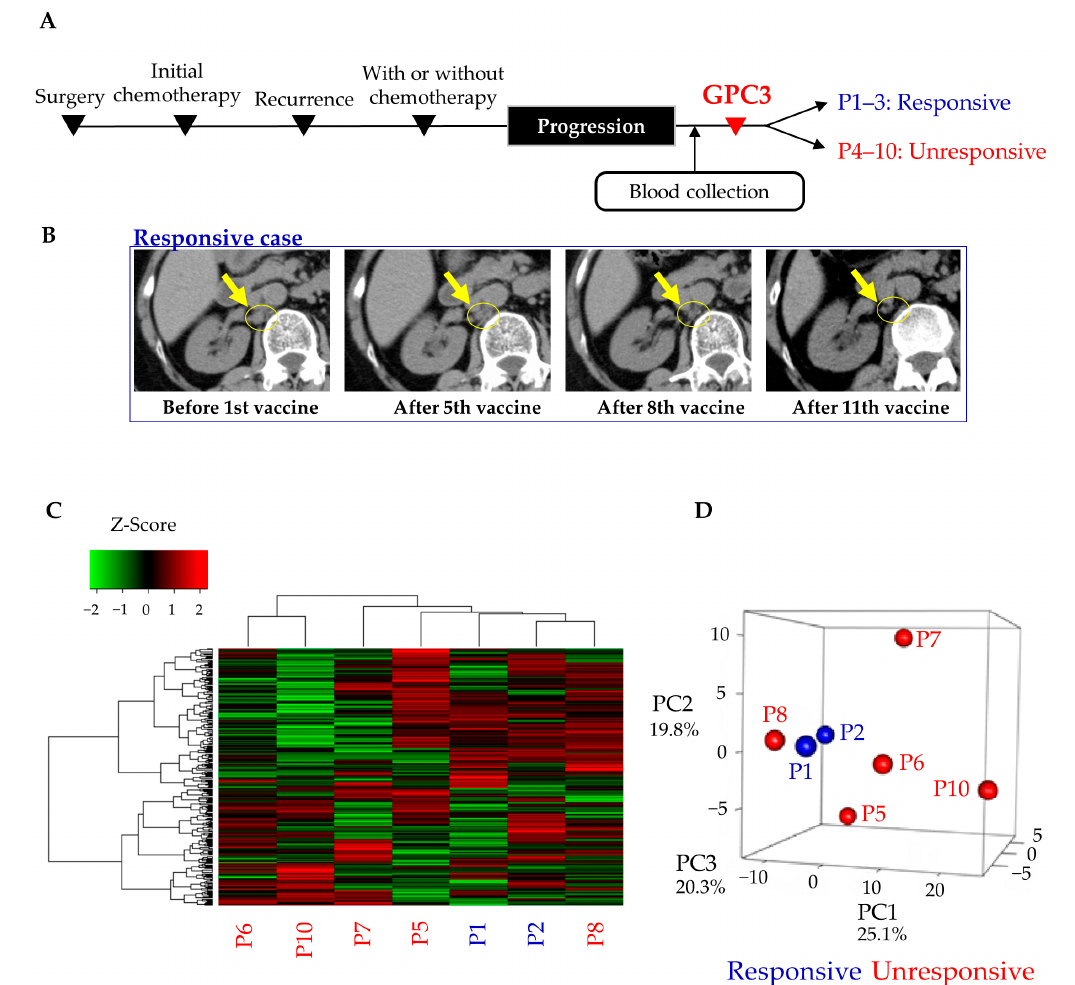
Figure 3. Comprehensive serum miRNA sequencing in the progression group. ( A ) Time line chart of the remission group; ( B ) representative images of a responsive case. A computed tomography scan showed that paraaortic lymph node metastases shrunk with GPC3 peptide vaccine treatment in the P2 case; ( C , D ) heatmap and principal component analysis of serum miRNA profiles. Blue and red letters indicate responsive (P1 and P2) and unresponsive (P5–8 and P10) cases, respectively. P3, P4, and P9 were excluded because of low read counts. P,